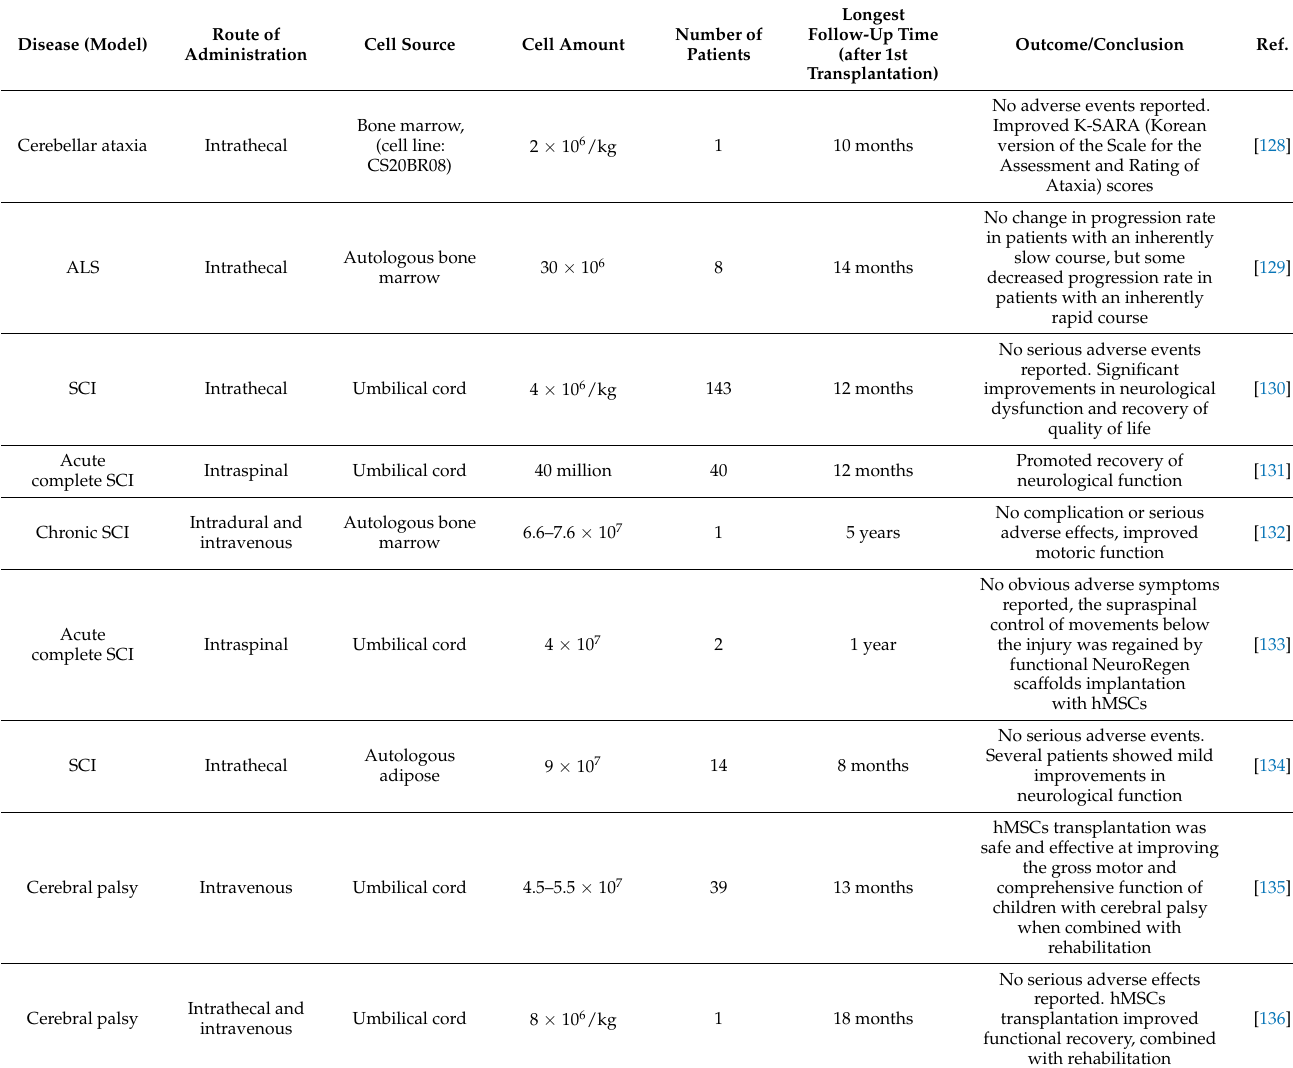
Table 5. Examples of hMSCs transplantation for neurological disorders in clinical trials (data from PubMed).